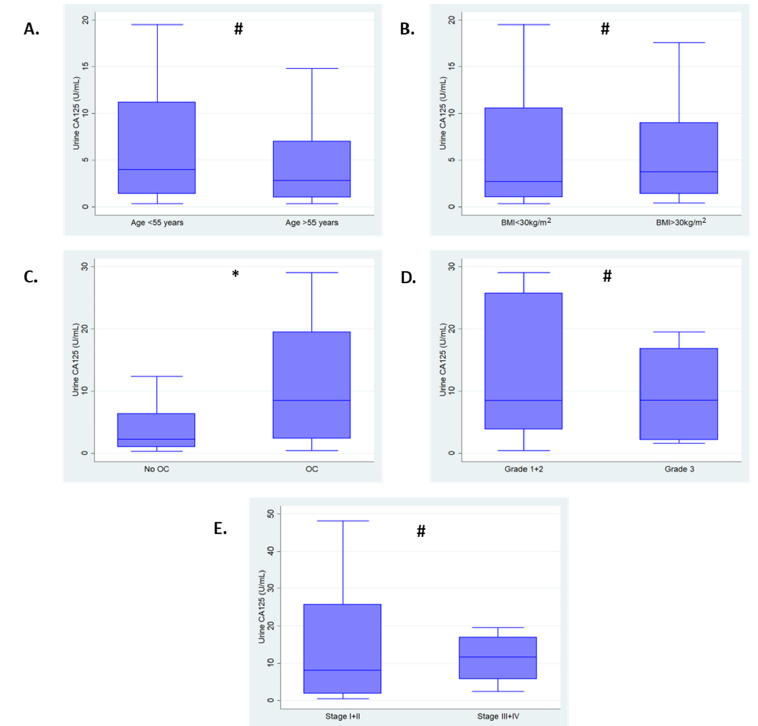
Figure 1. Box plots of urine CA125 (U/mL) levels and clinico ‐ pathological features. ( A ) Age (<55 years vs. >55 years). ( B ) BMI (<30 kg/m 2 vs. >30 kg/m 2 ). ( C ) Disease status (no ovarian cancer vs. ovarian cancer). ( D ) Grade (low grade vs. high grade). ( E ) FIGO Stage (early stage vs. late stage). Significance calculated using Mann ‐ U Whitney test * p ‐ value < 0.05. # p ‐ value ≥ 0.05. Outliers excluded from plots. OC—ovarian cancer.